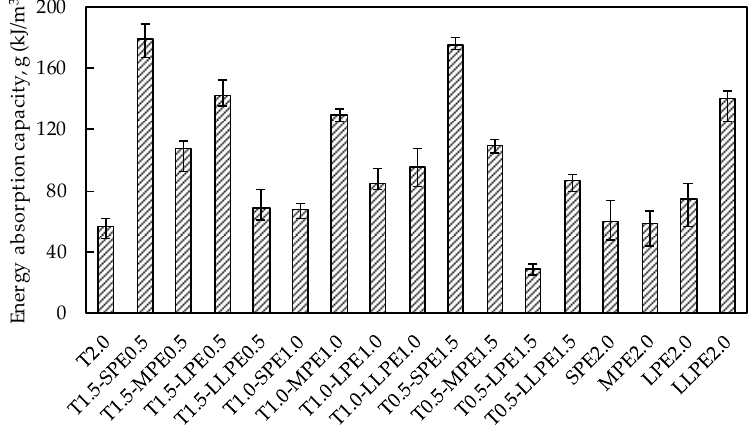
Figure 6. Energy absorption capacity analysis up to the peak point of UHPCCs.